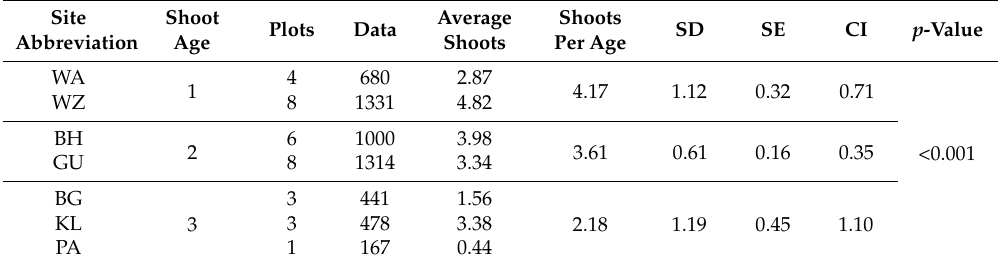
Table 3. Average number of shoots per stump and per age class as well as the plot and shoot